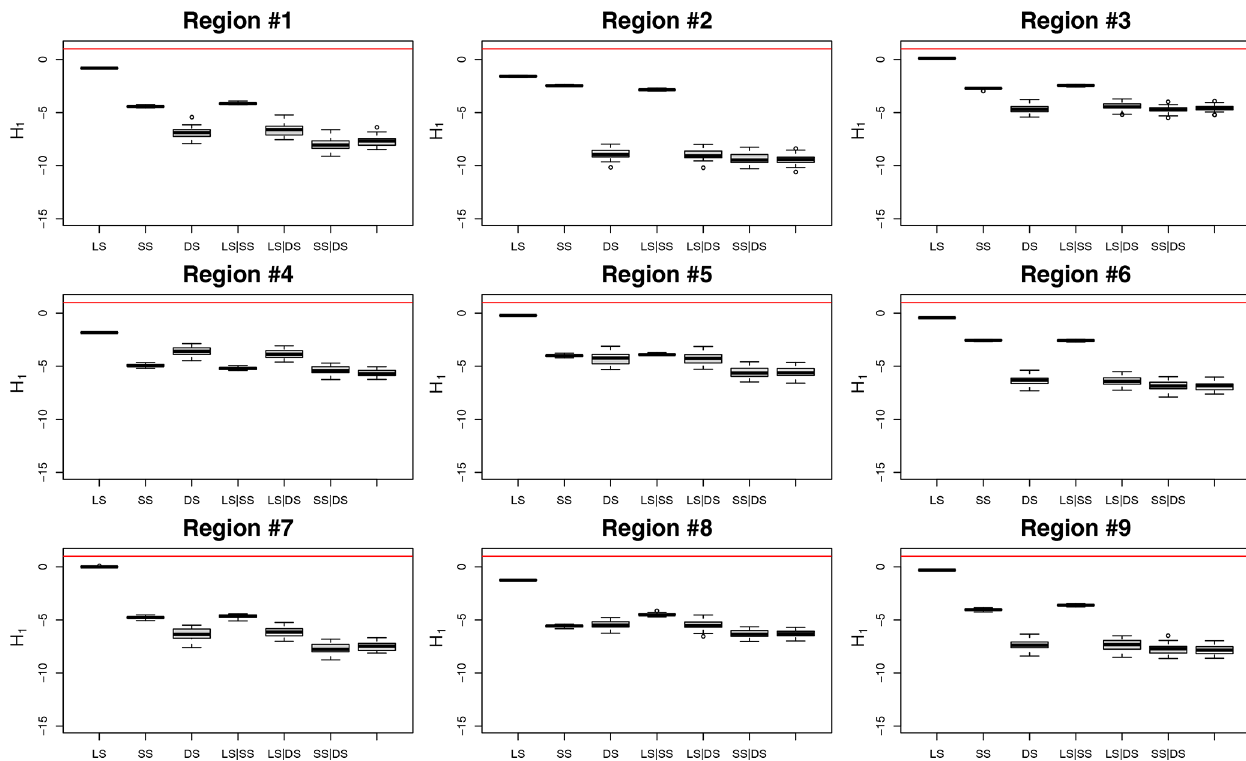
Figure A2. The homogeneity index (H 1 ) computed for each of the ninth selected regions for each of the dataset combinations.